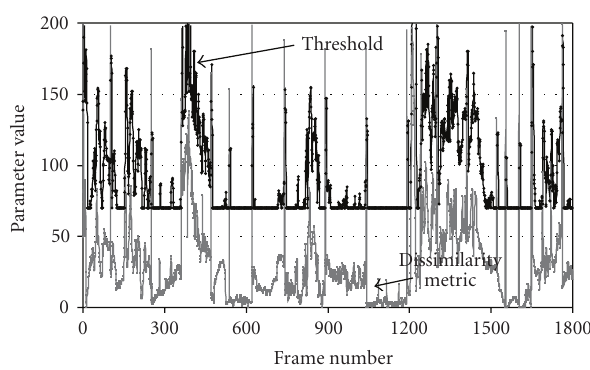
Figure 8: Threshold T ( n ) and dissimilarity metric X i variations over a whole 12.5 fps video sequence with no